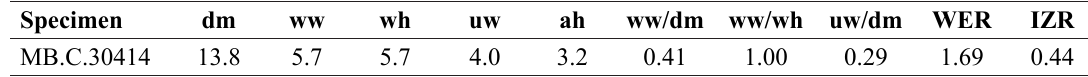
Table 5. Conch dimensions and ratios of specimen MB.C.30414 of Paucitornoceras paucistriatum gen. et comb. nov. (d’Archiac & de Verneuil, 1842).